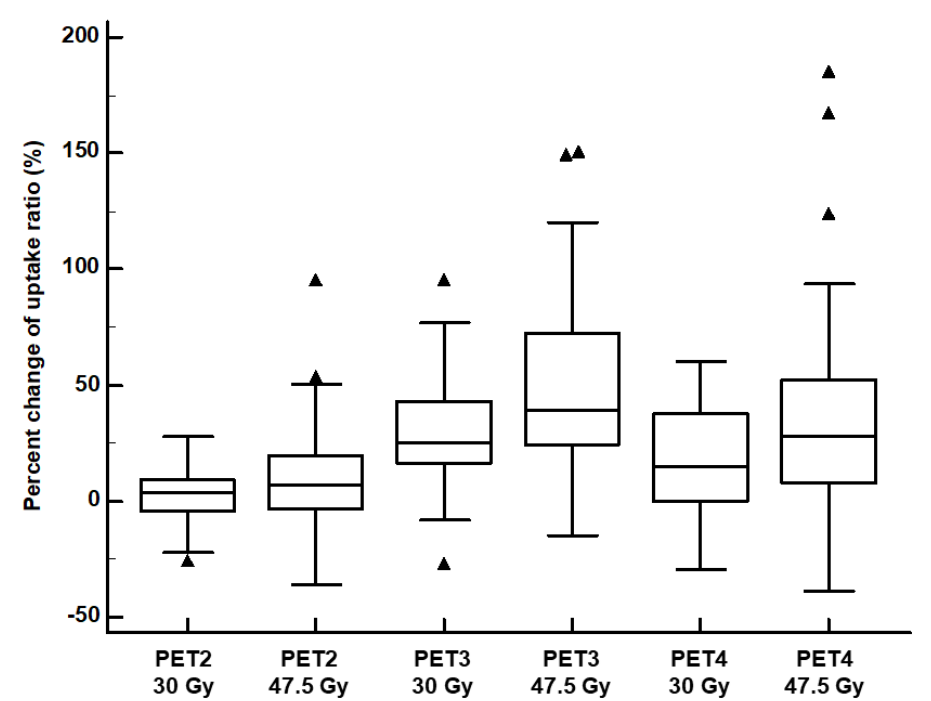
Figure 5. Distributions of percent changes in the 30 Gy-irradiated myocardium-to-low-irradiated myocardium F-18 Fluorodeoxyglucose (FDG) uptake ratio (30 Gy uptake ratio) and 47.5 Gy-irradiated myocardium-to-low-irradiated myocardium FDG uptake ratio (47.5 Gy uptake ratio) on sequential FDG positron emission tomography / computed tomography (PET / CT). (PET2 30 Gy, percent change in the 30 Gy uptake ratio on PET / CT after the completion of the adjuvant chemotherapy; PET2 47.5 Gy, percent change in the 47.5 Gy uptake ratio on PET / CT after the completion of the adjuvant chemotherapy; PET3 30 Gy, percent change in the 30 Gy uptake ratio on PET after the completion of the adjuvant radiotherapy; PET3 47.5 Gy, percent change in the 47.5 Gy uptake ratio on PET after the completion of the adjuvant radiotherapy; PET4 30 Gy, percent change in the 30 Gy uptake ratio on surveillance PET / CT; PET4 47.5 Gy, percent change in the 47.5 Gy uptake ratio on surveillance PET / CT). (Central box, the values from the 25 percentile to 75 percentile; middle line in the box, median value; error bar, extending from the minimum value to the maximum value except outside values; marker, an outside value which is smaller than 25 percentile minus 1.5 times the interquartile range or larger than the 75 percentile value plus 1.5 times the interquartile range).